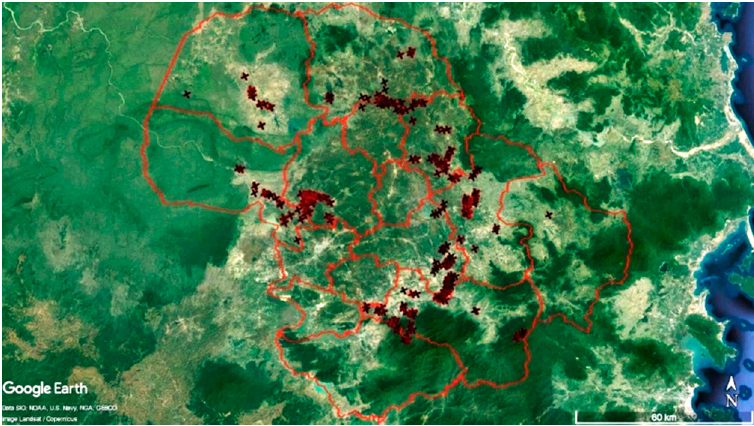
Figure 3. Distribution of visited maize fields within the district boundary of Dak Lak province, Vietnam.